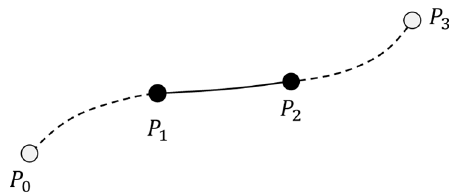
Figure 3. Single path used to connect 𝑃 (cid:2869) and 𝑃 (cid:2870) using Catmull–Rom spline.